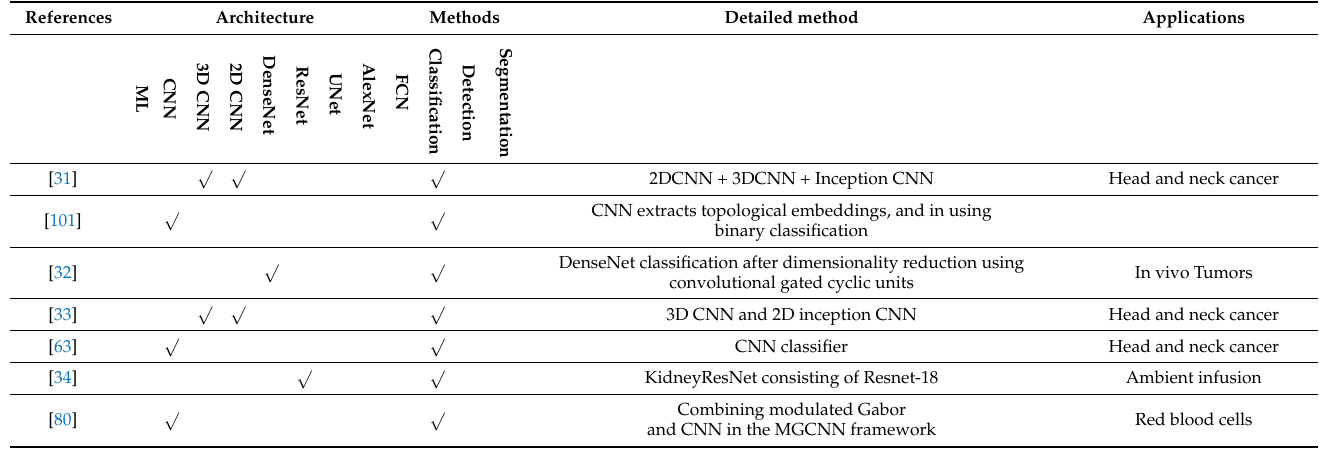
Table 4. Summary of common deep learning architectures and